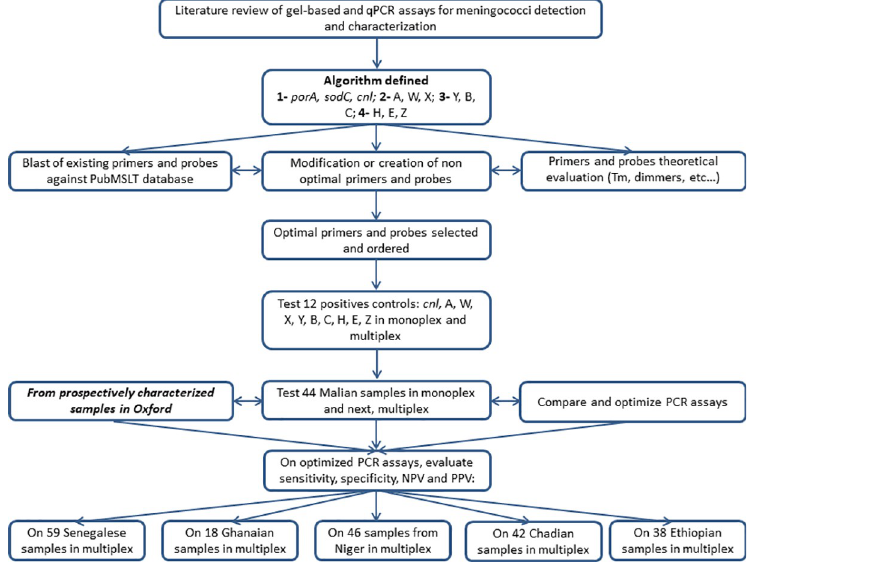
Fig 1. Summary of the methodology employed in the study and samples tested.